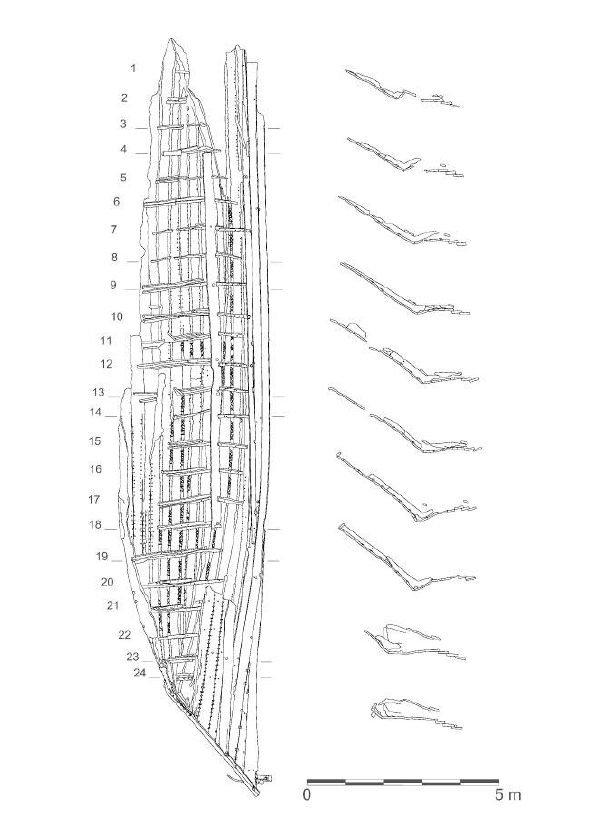
Figure 14. Plan and sections of the hull.